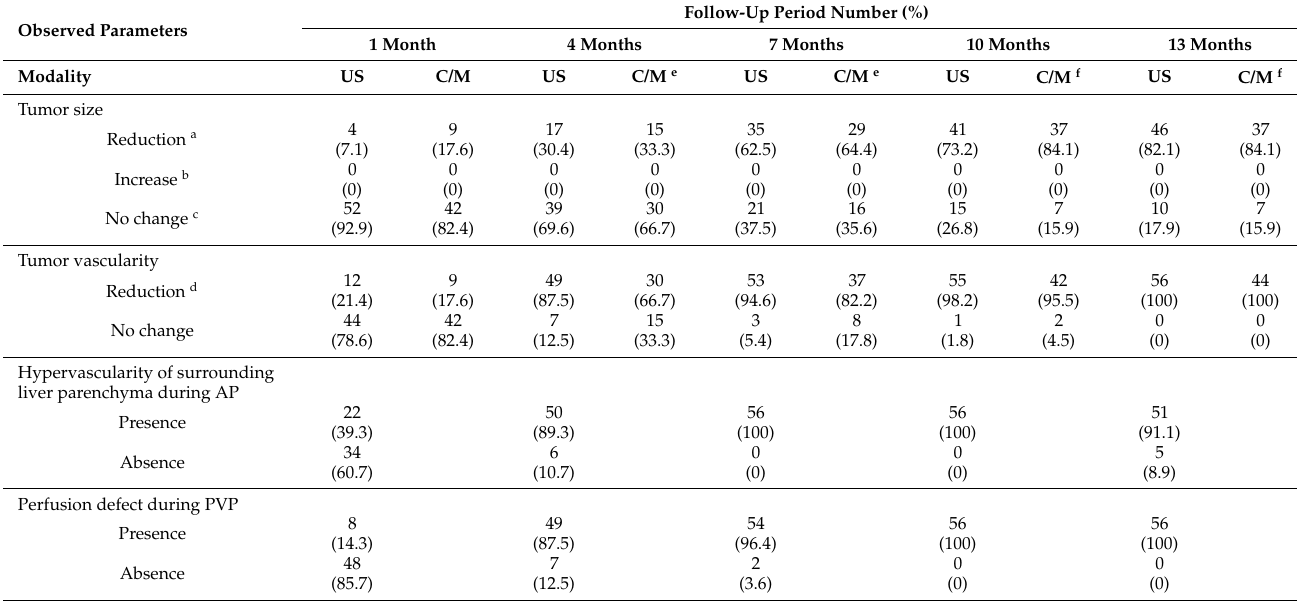
Table 2. Changes in SCEUS (N = 56) and CECT/CEMRI (N = 51) findings during 13 months after RT for no local recurrence